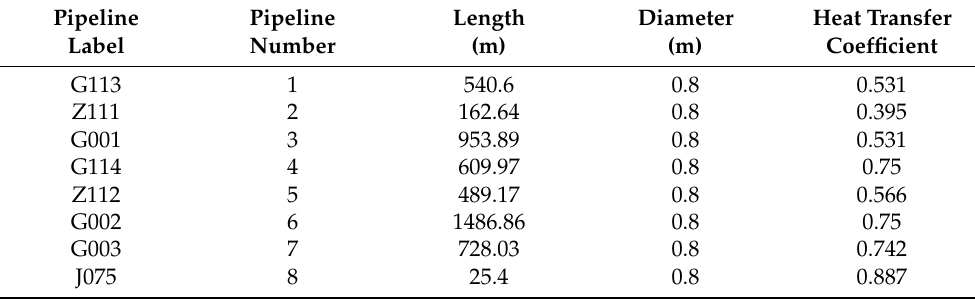
Table A1. Pipeline parameters of the nine-node double-heat-source tree steam heating network.